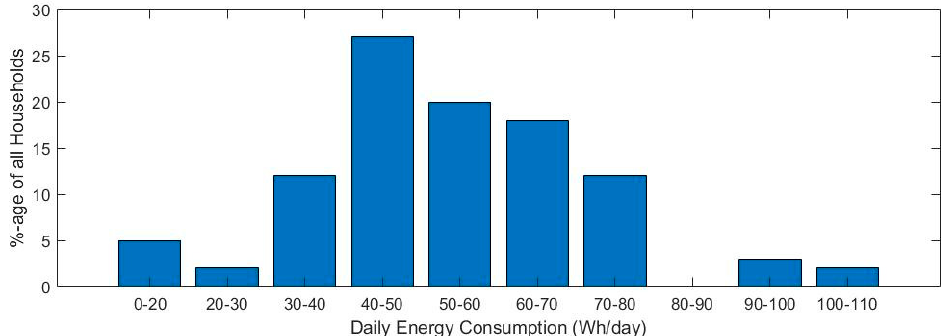
Figure 5. Average daily demand diversity across 64 SHSs.